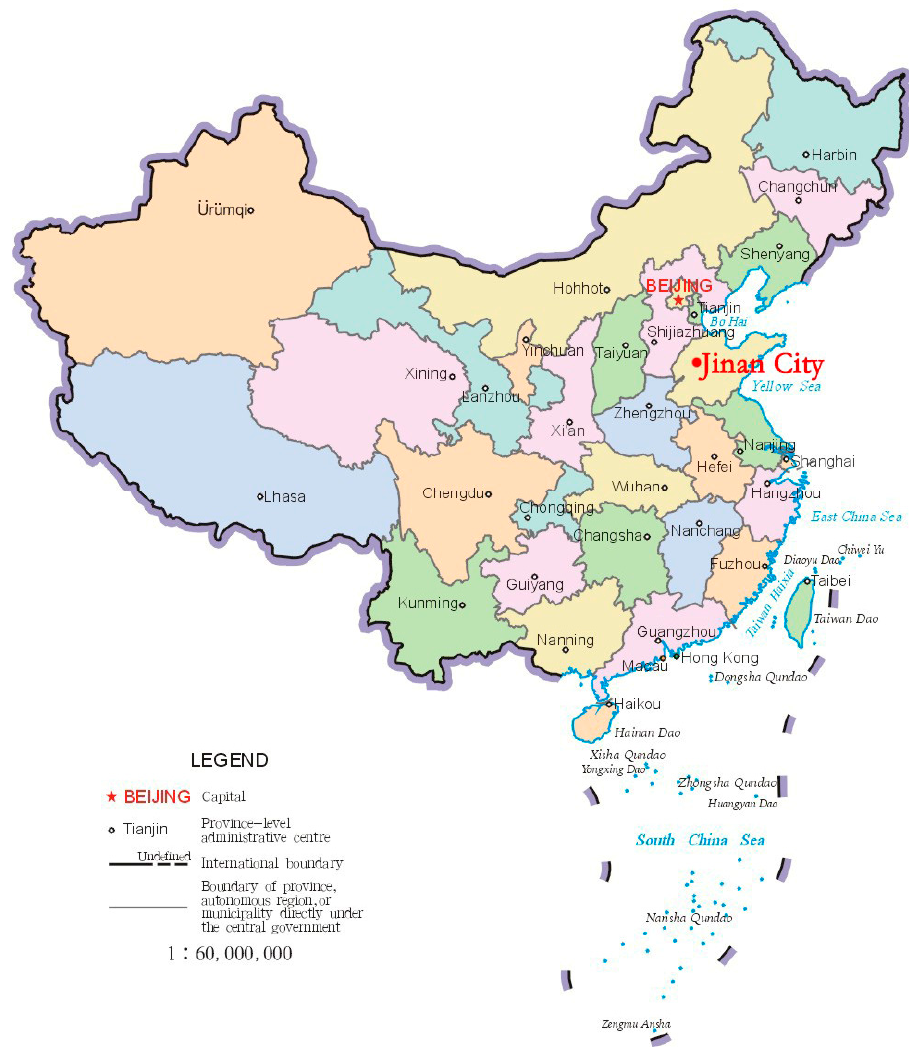
Figure 1. Location map of Jinan City (Form Standard map service: http://bzdt.ch.mnr.gov.cn, accessed on 22 February 2022).